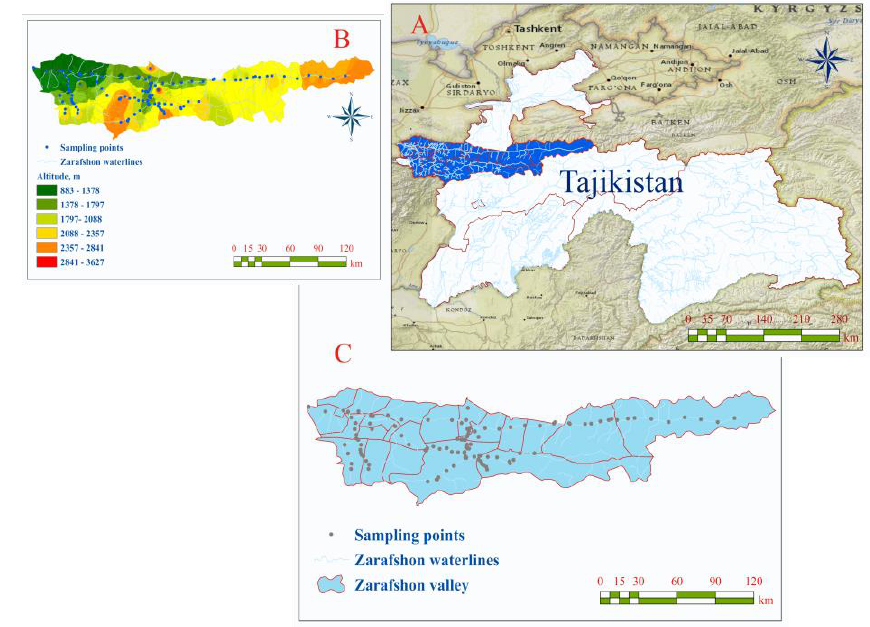
Figure 1. Investigated area location in the Tajikistan map ( A ); altitude (meter) of the investigated area, respectively by sampling points ( B ); soil and sediment sampling sites of Zarafshon Valley ( C ).